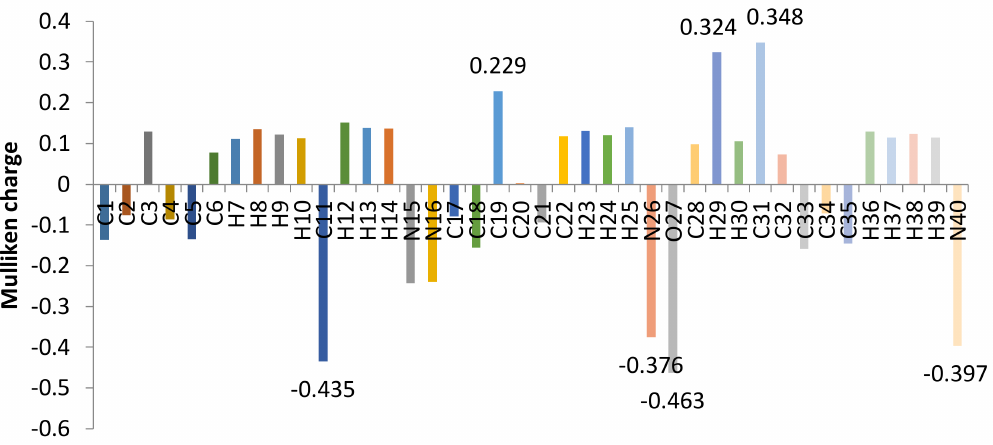
Figure 4. Mulliken Charge Distribution of ligand,